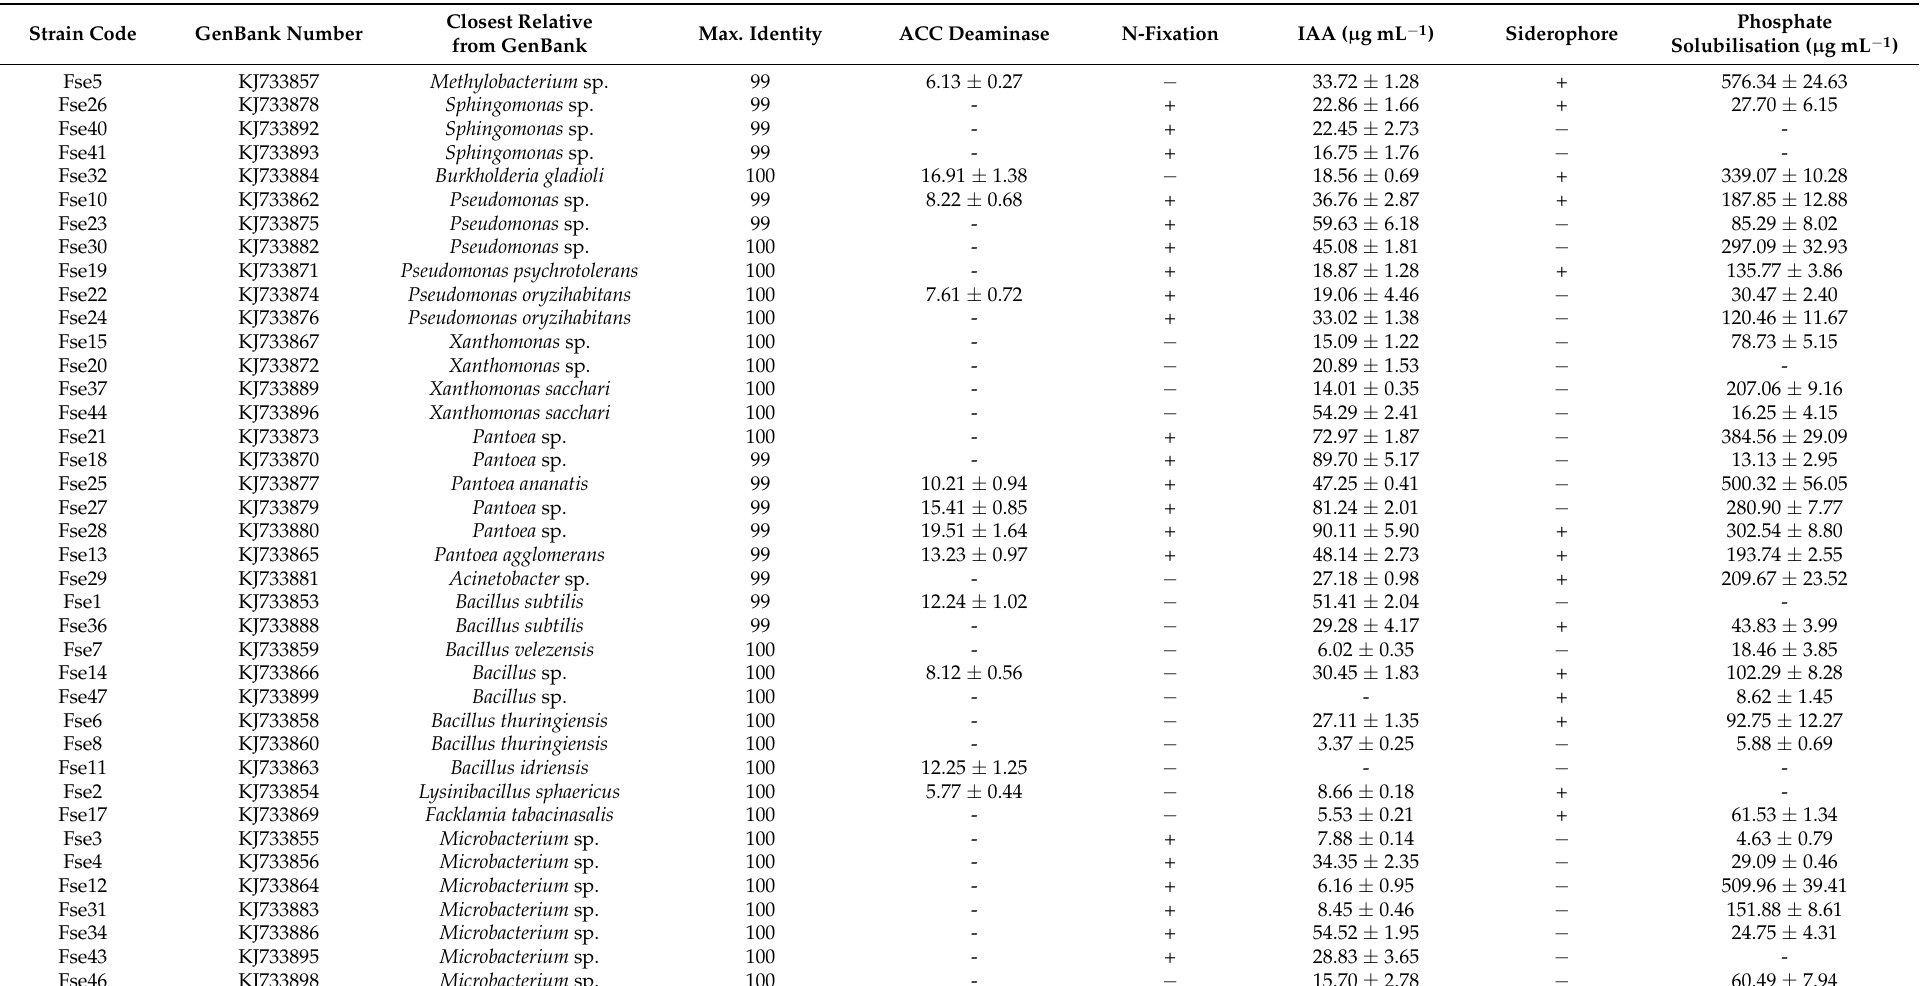
Table 2. Summary of the endophytic bacteria isolated from DXWR seeds together with their respective strain codes, GenBank accession numbers, closest affiliations among the representative isolates in GenBank according to 16S rRNA sequence analysis, and PGP